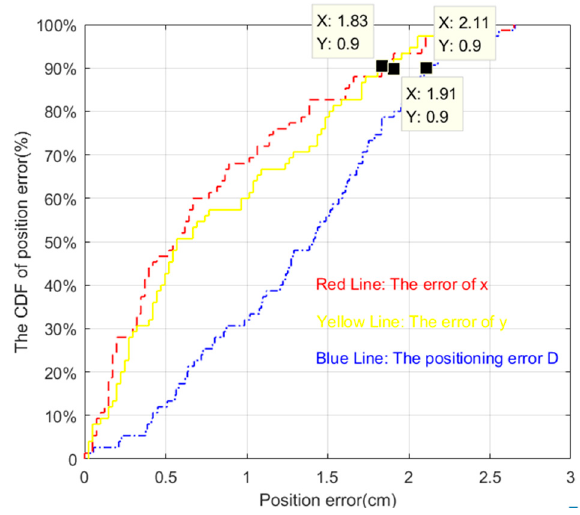
Figure 22. The CDF of positioning error when random areas of the LED was shielded.